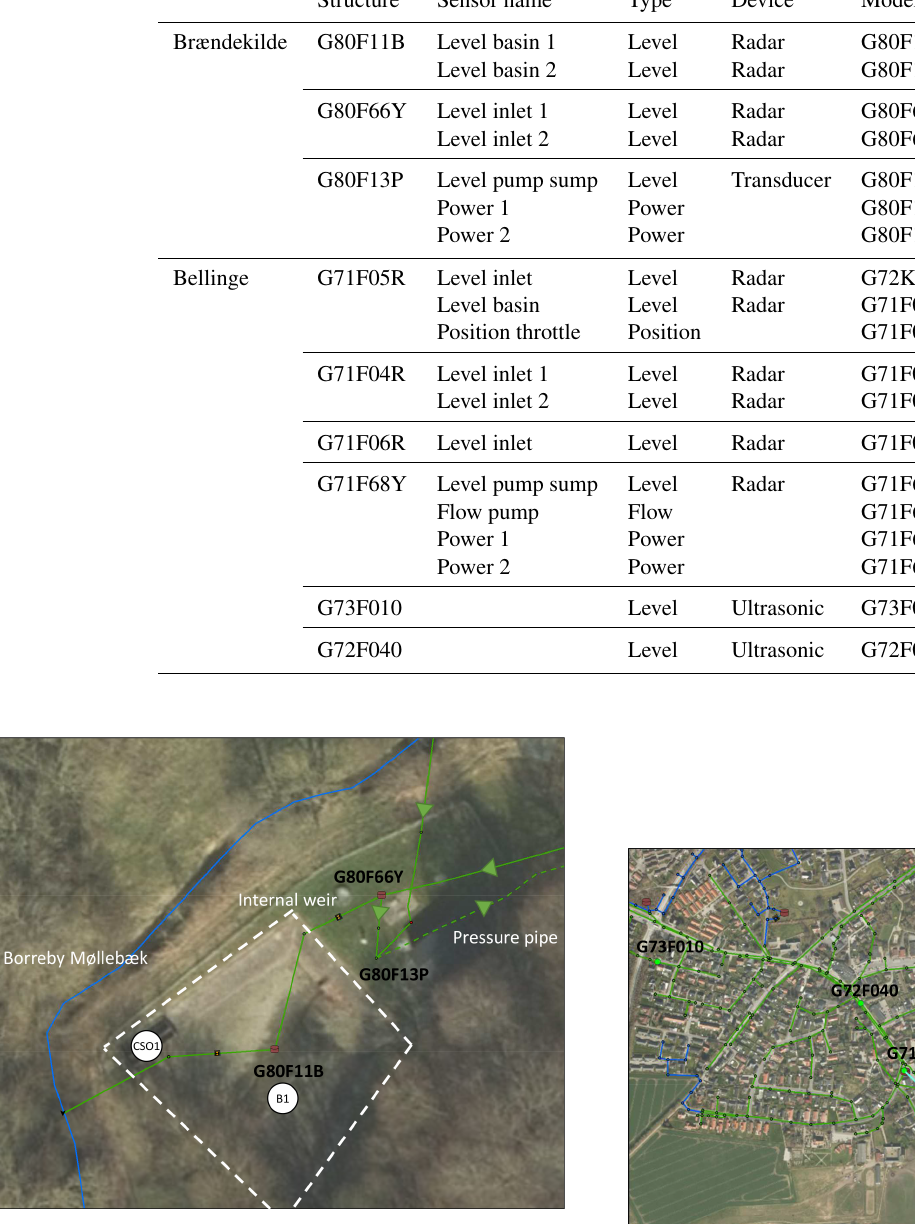
Figure 5. Location of the hydraulic structures at Brændekilde, where observations are obtained. Basin B1 and CSO1 are located here. Background maps provided by DADSE (2020).